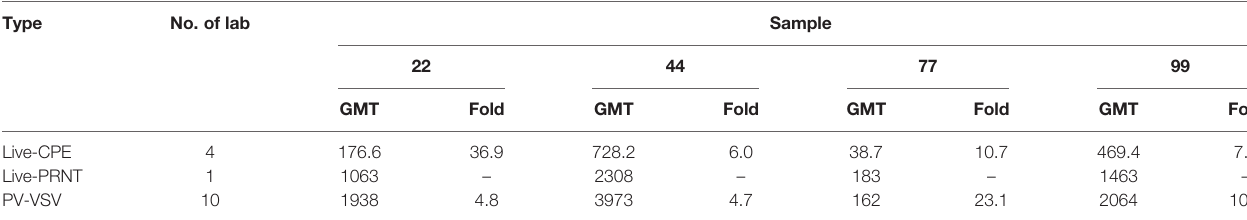
TABLE 5 | Comparison of geometric mean of SARS-CoV-2 neutralising antibodies reported in ref. (118).